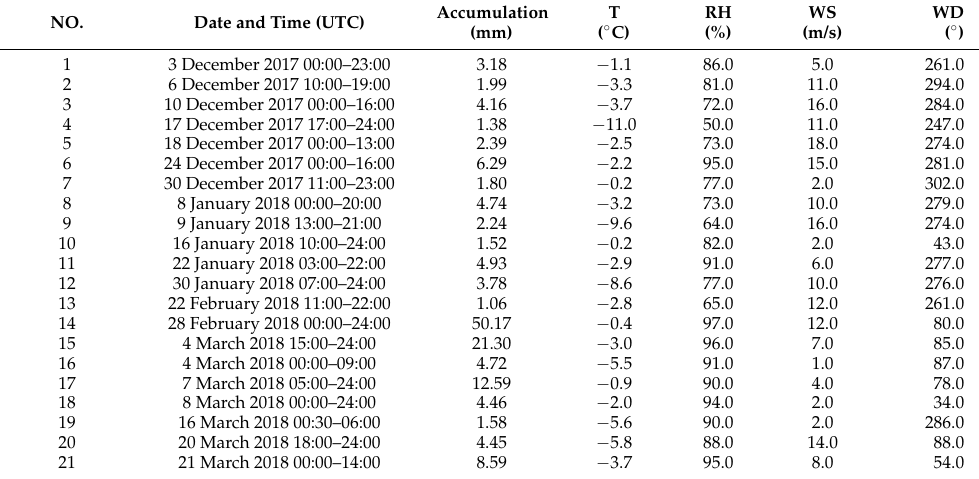
Table 1. Snow events used to for analysis in this study. Meteorological conditions are listed, including the accumulation of snowfall, temperature (T), relative humidity (here abbreviated as RH), wind speed (WS), and wind direction (WD). The date is in